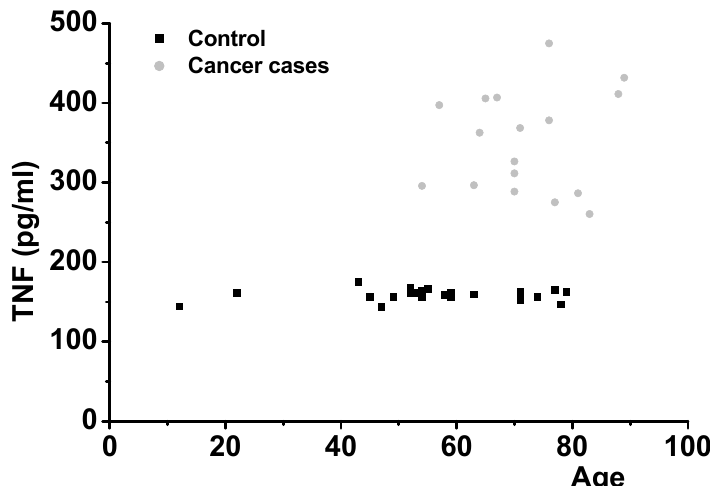
Figure 4. TNF levels in controls and cancer cases were tested. Averages and SD were 159.18 ± 7.38 for controls (25 cases) and 351.53 ± 63.8 for cancer cases (17 cases). The values ranged from 260 pg / mL to 474 pg / mL. There was no overlap between normal and cancer cases. One-way ANOVA was carried out to test the significance of the data: p < 0.01 between controls and cancer cases.